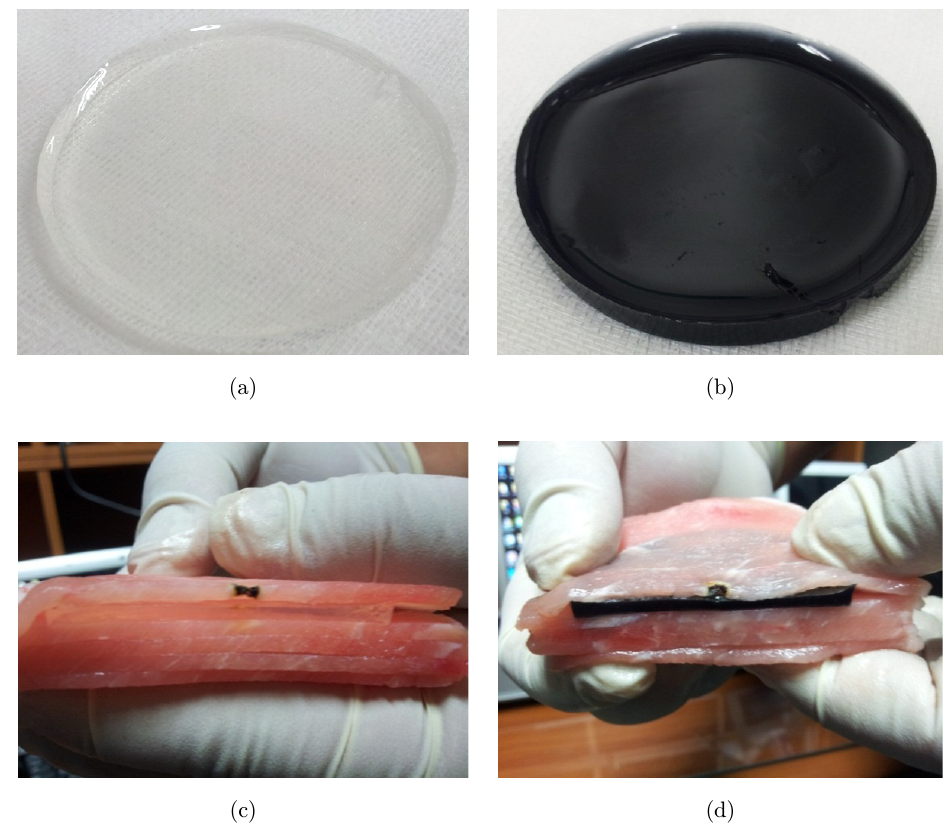
Fig. 3. Multi-layered porcine tissue-agar gel model. Agar gel of 1% concentration was used as a SFC material. (a) Normal gel, (b) black gel, (c) tissue sample with normal gel under the top layer after laser irradiation, and (d) tissue sample with black gel under the top layer after laser